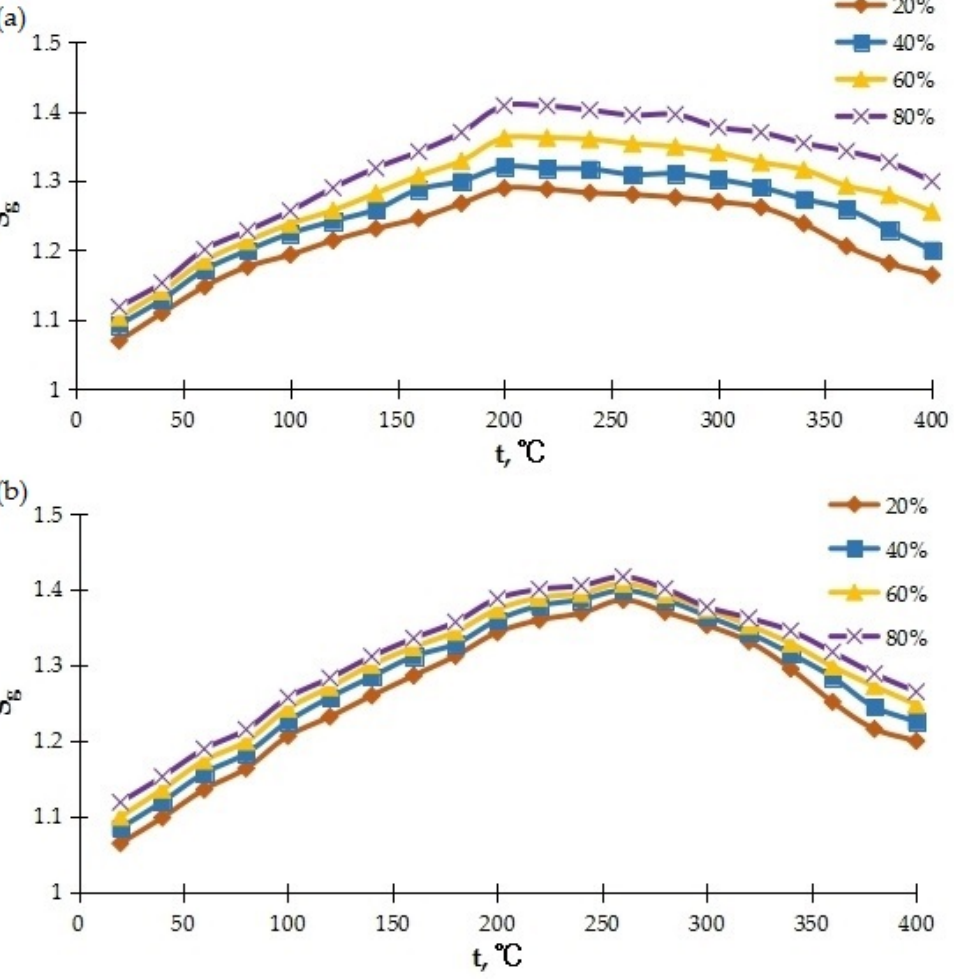
Figure 5. Temperature dependence of the gas-sensitive response of thin films obtained on the GaAs surface under the influence of various compositions Y 2 O 3 + Sb 2 O 3 , in the presence of the following gases in the atmosphere: ( a ) CO, ( b ) NH 3 .